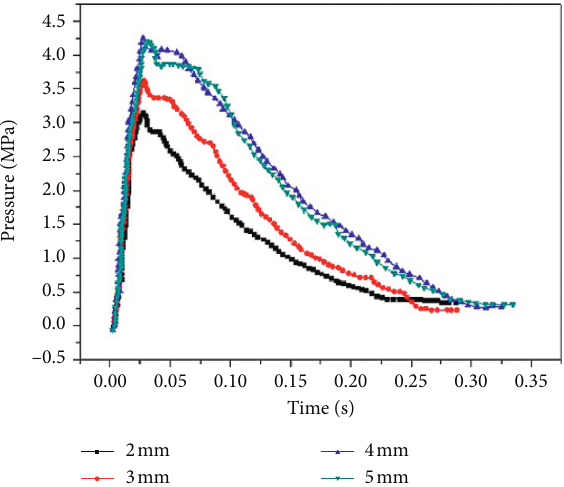
Figure 16: Comparison of the pressure-time curves of the target plates with different